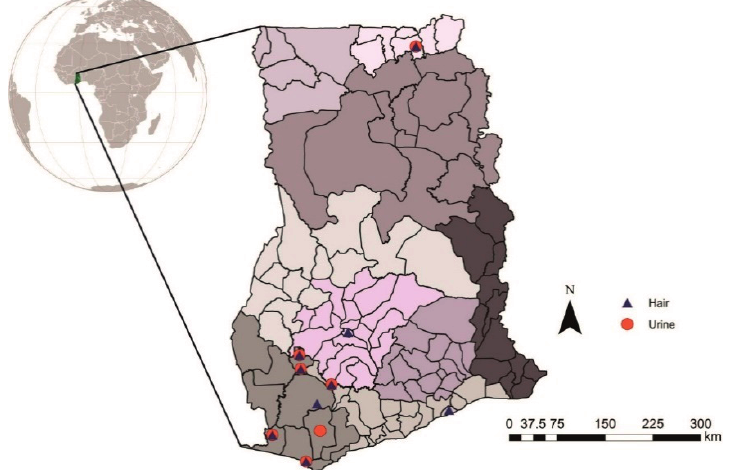
Figure 3. Map of sampling sites of studies on mercury in human hair and urine in